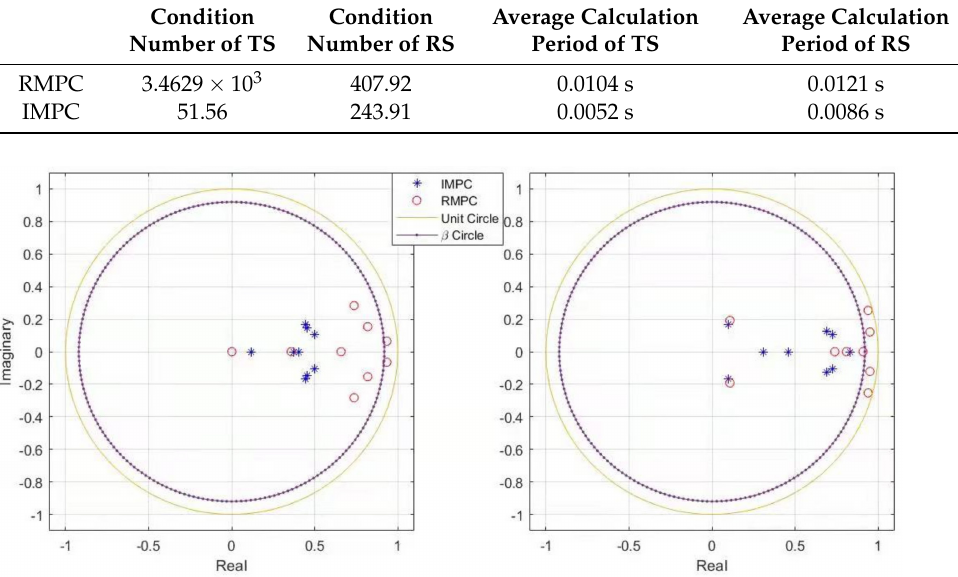
Table 1. Condition number of the RMPC and IMPC.